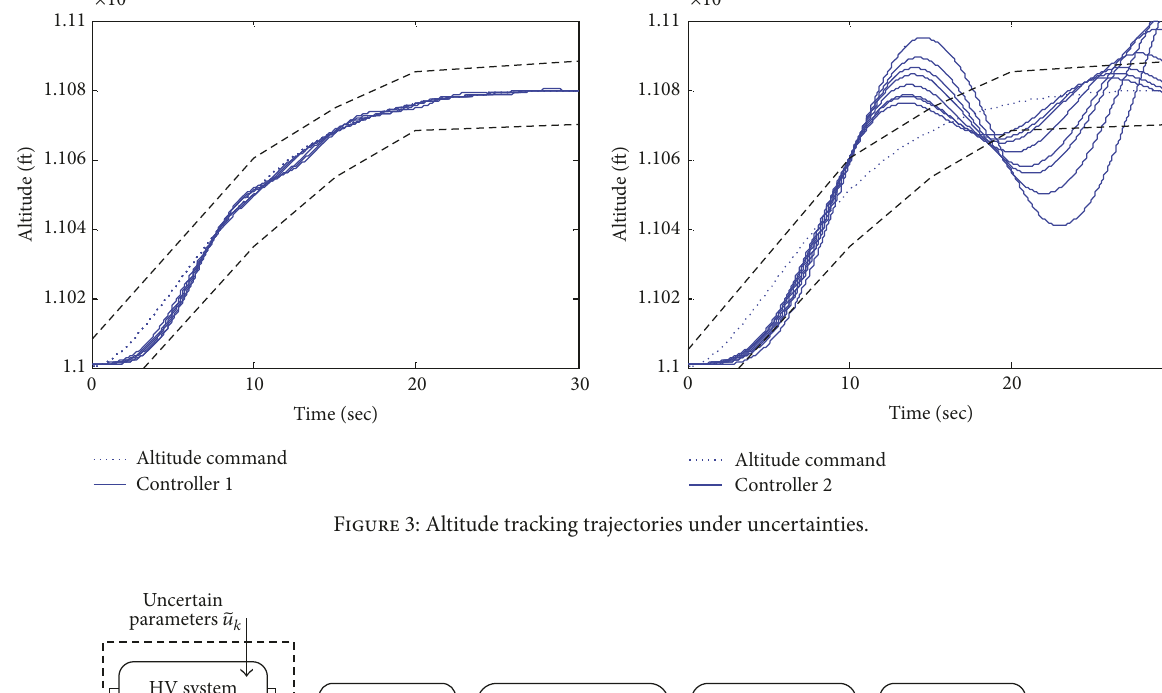
Figure 3: Altitude tracking trajectories under uncertainties.